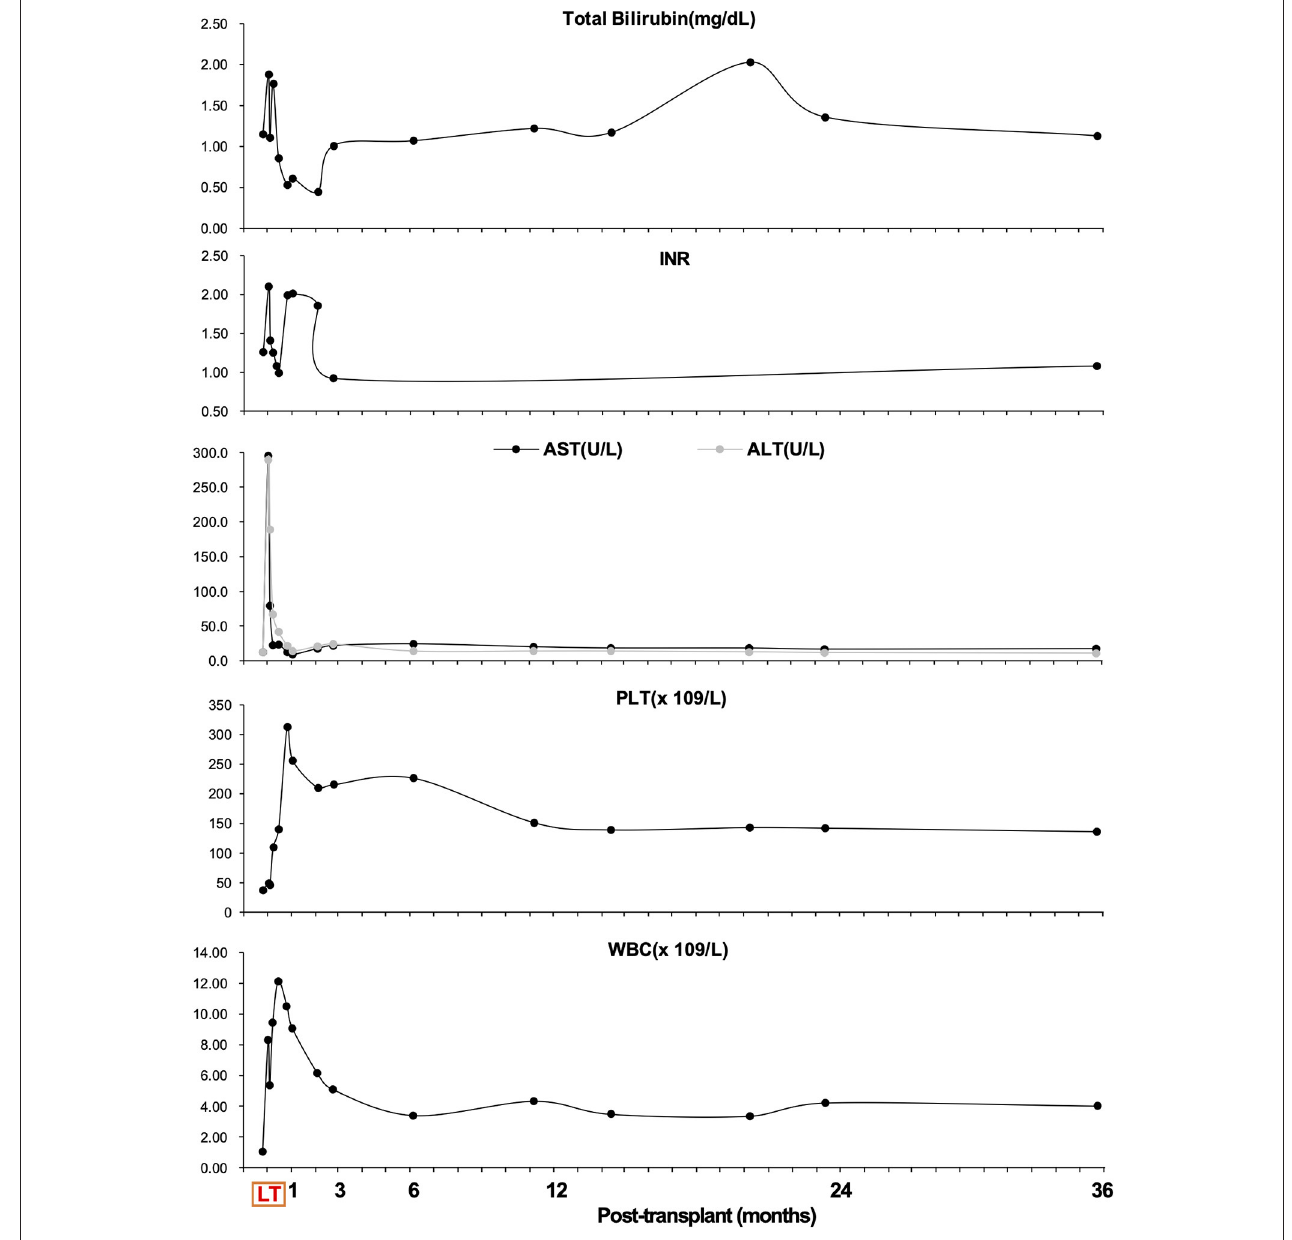
FIGURE 2 | Overview of total bilirubin (mg/dl), international normalized ratio (INR), aspartate aminotransferase (AST, U/L), alanine aminotransferase (ALT, U/L), platelet (PLT, 10 9 /L) count, and white blood cell (WBC, 10 9 /L) count during